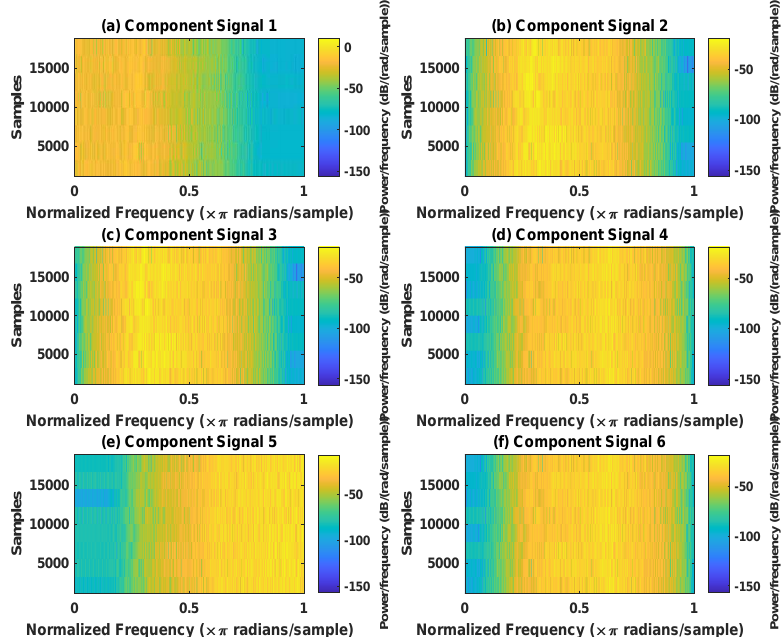
Figure 7. Decomposition results of SVDP with m = 16 and J = 3: ( a – f ) time–frequency diagram of 1st to 6th subcomponents, respectively.